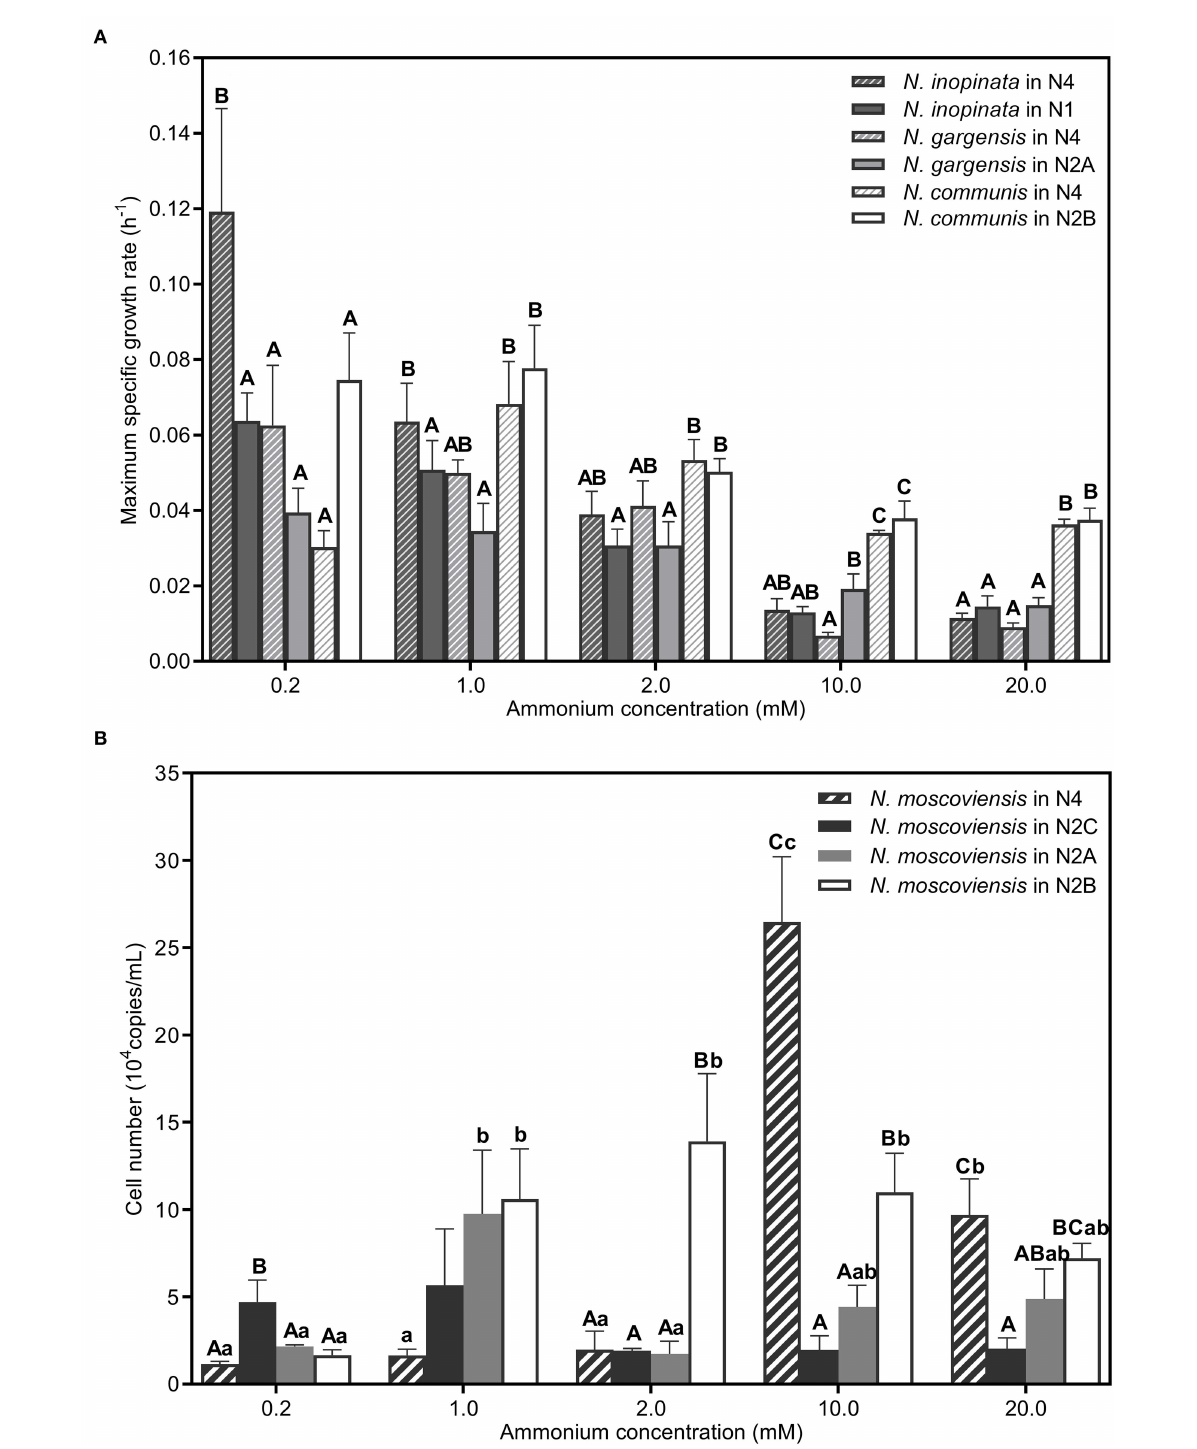
FIGURE5 Maximum specific growth rates or cell numbers of nitrifiers in different SNCs. (A) Comparation of the maximum specific growth rate of N. inopinata , N. gargensis , and N. communis in different SNCs (N2A, N2B, N2C, and N4). (B) Cell numbers of N. moscoviensis in different SNCs (N2A, N2B, N2C, and N4). Data are presented as mean ± SE ( n = 4). Different capital letters mean a statistical significance ( P < 0.05) among the five ammonium concentrations for the same community, and different small letters mean a statistical significance ( P < 0.05) among different communities under the same ammonium